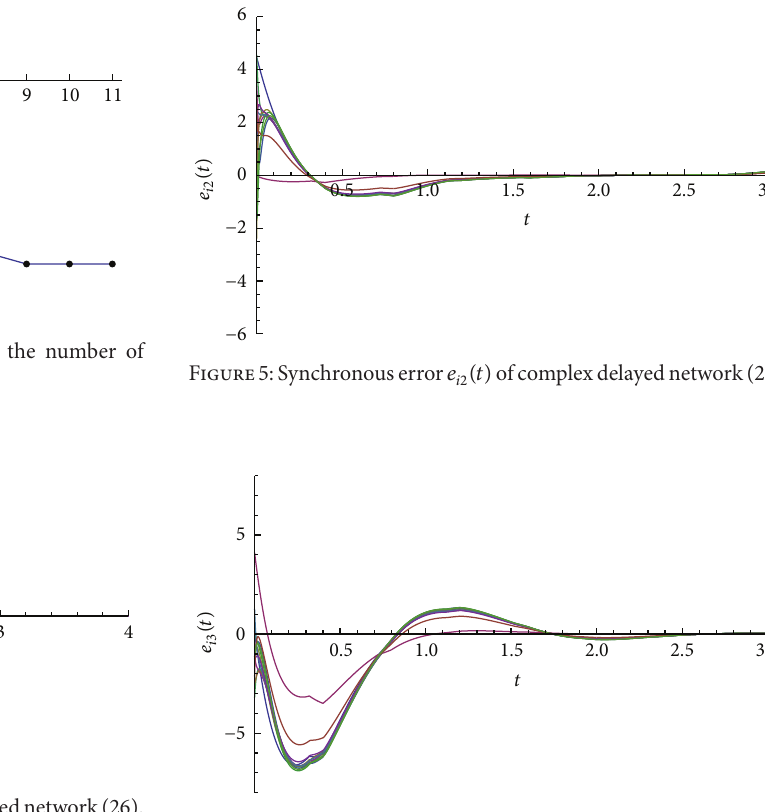
consensus of multiagents system (including first- or second- order) such as those described in [24,